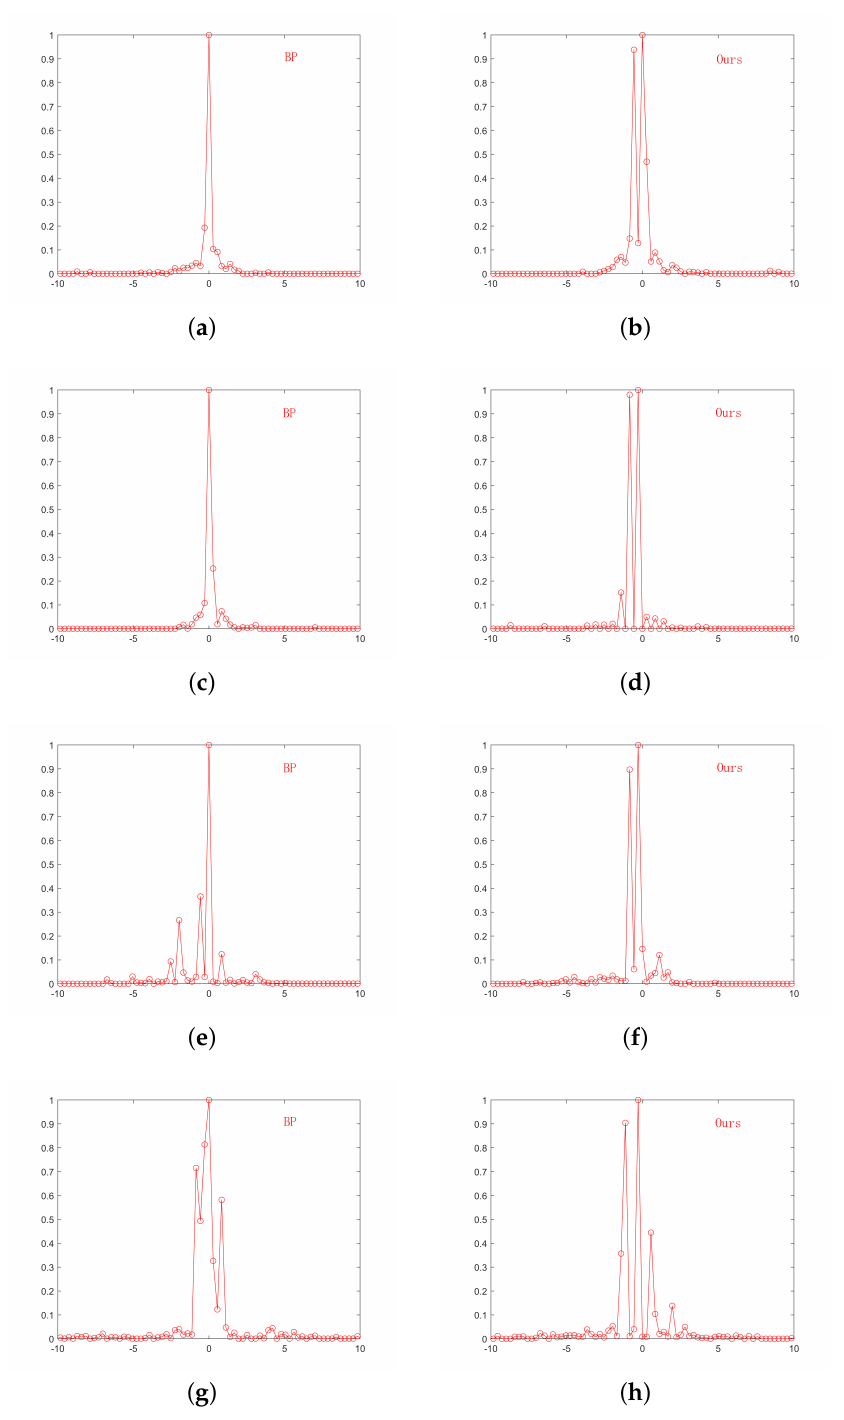
Figure 14. Comparison of reconstruction performance in layover points. ( a ) BP reconstruction result of point 1 and point 2. ( b ) Proposed method reconstruction result of point 1 and point 2. ( c ) BP reconstruction result of point 3 and point 4. ( d ) Proposed method reconstruction result of point 3 and point 4. ( e ) BP reconstruction result of point 5 and point 6. ( f ) Proposed method reconstruction result of point 5 and point 6. ( g ) BP reconstruction result of point 7 and point 8. ( h ) Proposed method reconstruction result of point 7 and point